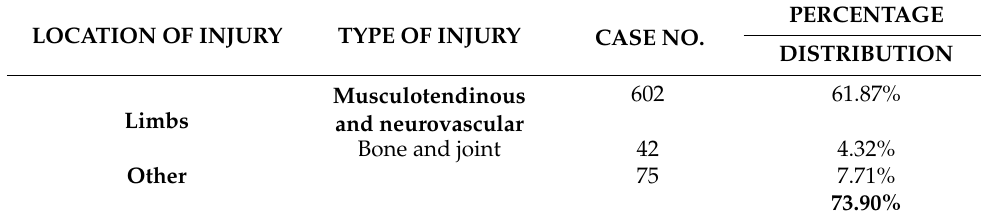
Table 2. Distribution of hospitalization diagnoses for wounds with mixed lesions. LOCATION OF